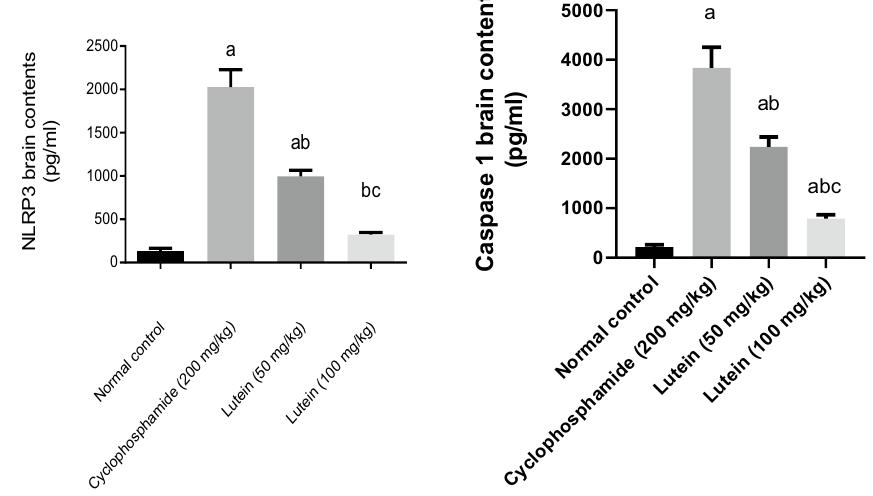
Figure 6. Effects of lutein on NLRP3 and caspase 1 brain contents. a Significant compared to the control group. b Significant compared to the Cyclophosphamide group. c Significant compared to Lutein 50 group at P < 0.05.